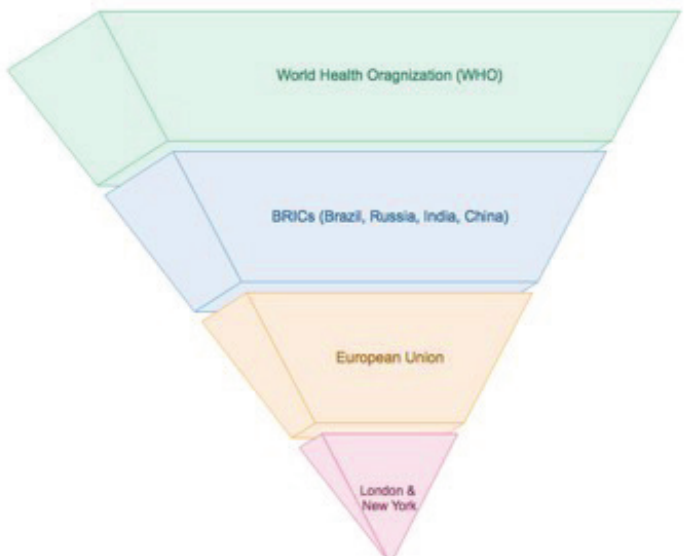
Figure 1. An inverted pyramid graph showing a top down approach of different regulatory government bodies for air pollution, illustrating the ways in which case studies are arranged in this